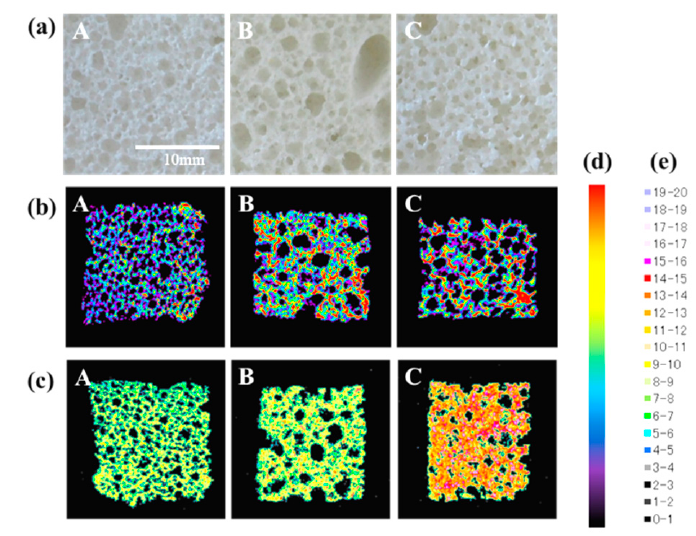
Figure 5. ( a ), Cross sections of breads A, B, and C. Magnetic resonance imaging of proton density weighted images ( b ) as well as T 2 distribution images ( c ) of the three breads. ( d , e ), color scale. Adapted from ref. 44 with permission.